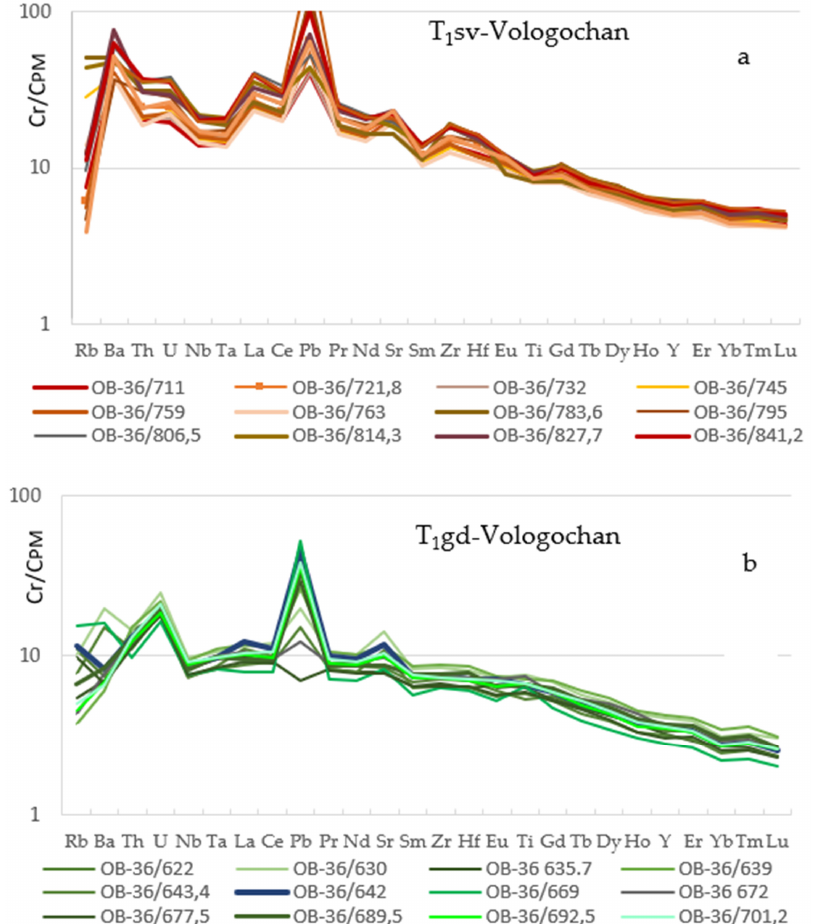
Figure 9. Spider diagrams for rocks of the Syverminsky ( a ) and Gudchikhinsky ( b ) Formations in the Vologochan syncline. Here and in Figures 10, 14, 15, 17, 21 normalized to primitive mantle [42].